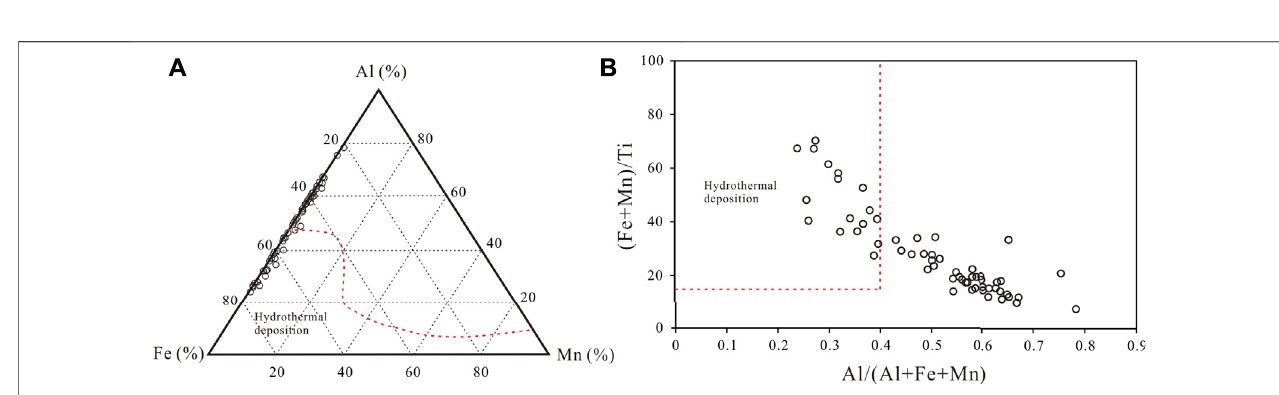
Frontiers in Earth Science |